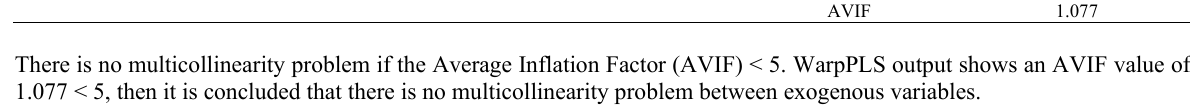
Full collinearity VIFs RC NET